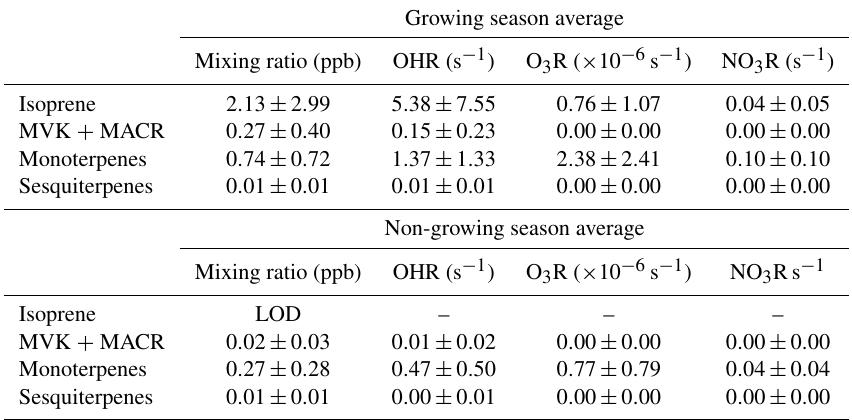
Table 2. Average and interquartile range of mixing ratio, OH (OHR), ozone (O 3 R), and nitrate (NO 3 R) reactivities in the growing and non-growing